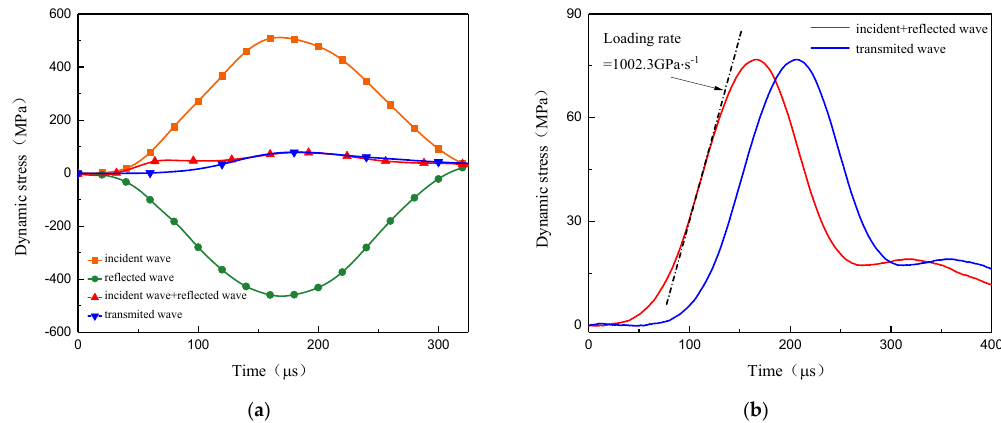
Figure 4. Curves of loads versus time (a) The dynamic stress curves detected from the incident bar and transmitted bar. (b) Determination method of the loading rate. transmitted bar. ( b ) Determination method of the loading